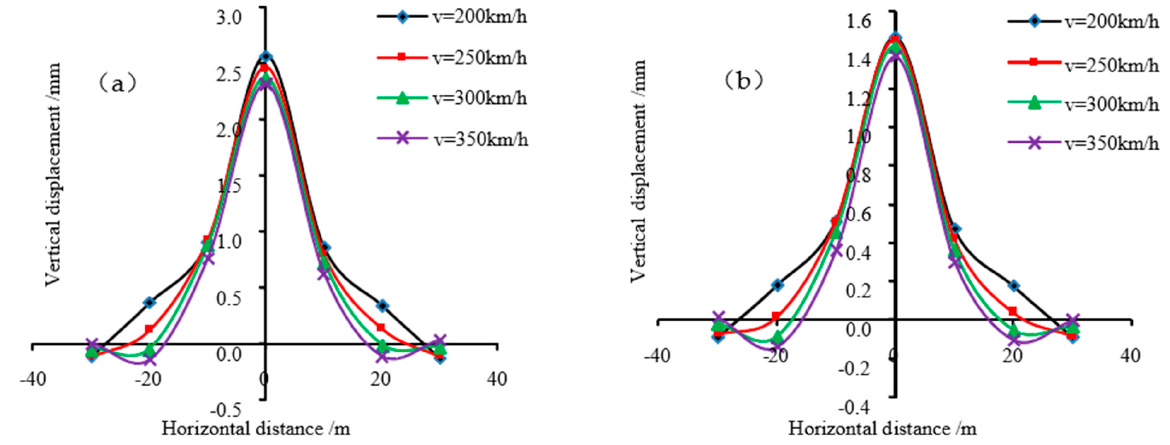
Figure 12. Vertical displacement distribution curves of surface soil at 0 m away from the fault and perpendicular to the high-speed railway line. ( a ) Upper wall 0 m away from the fault; ( b ) footwall 0 m away from the fault.